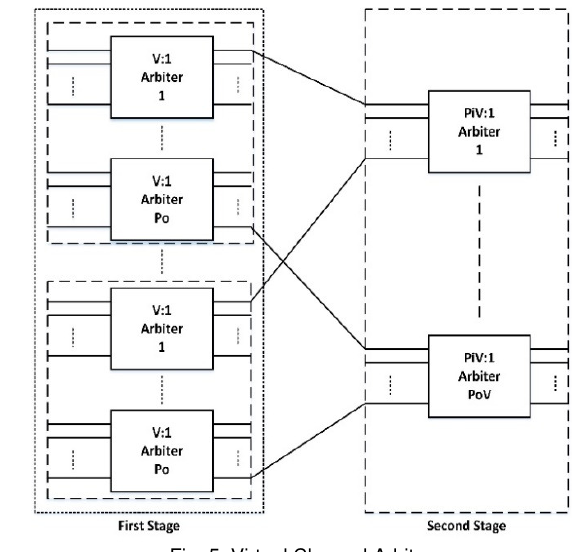
Fig. 5: Virtual Channel